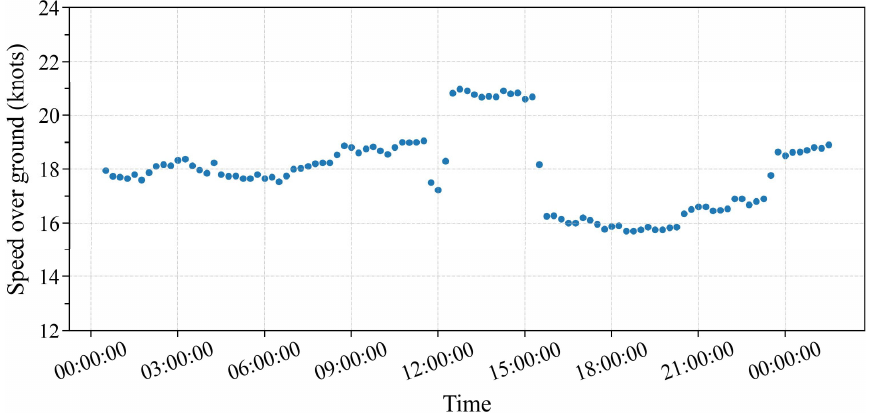
Figure 4. Changes in SOG within a day.